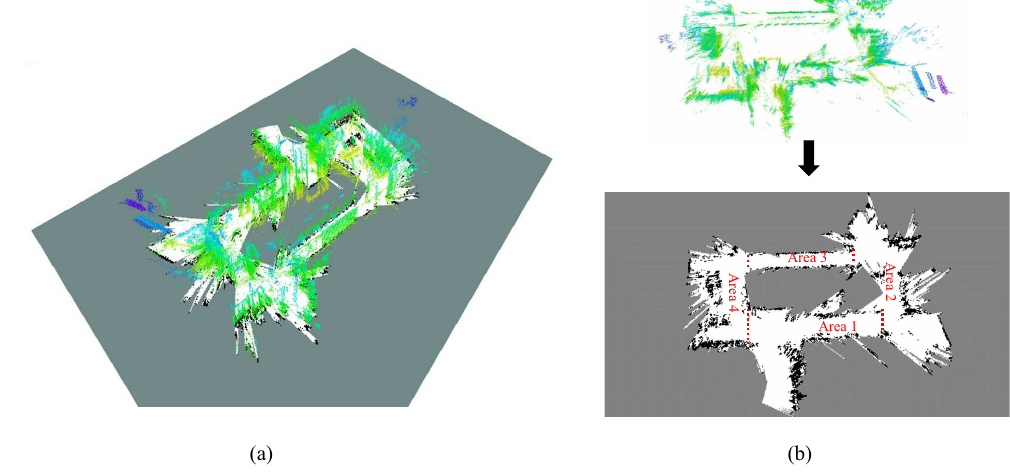
Figure 5. Map of the target environment, built based on the sequence ms-38 of the MIT Stata dataset [39]. ( a ) The point cloud map that is transformed to the map coordinate and its 2D projection. ( b ) The extracted 2D grid map. The same experimental setup has also been presented in our previous conference paper